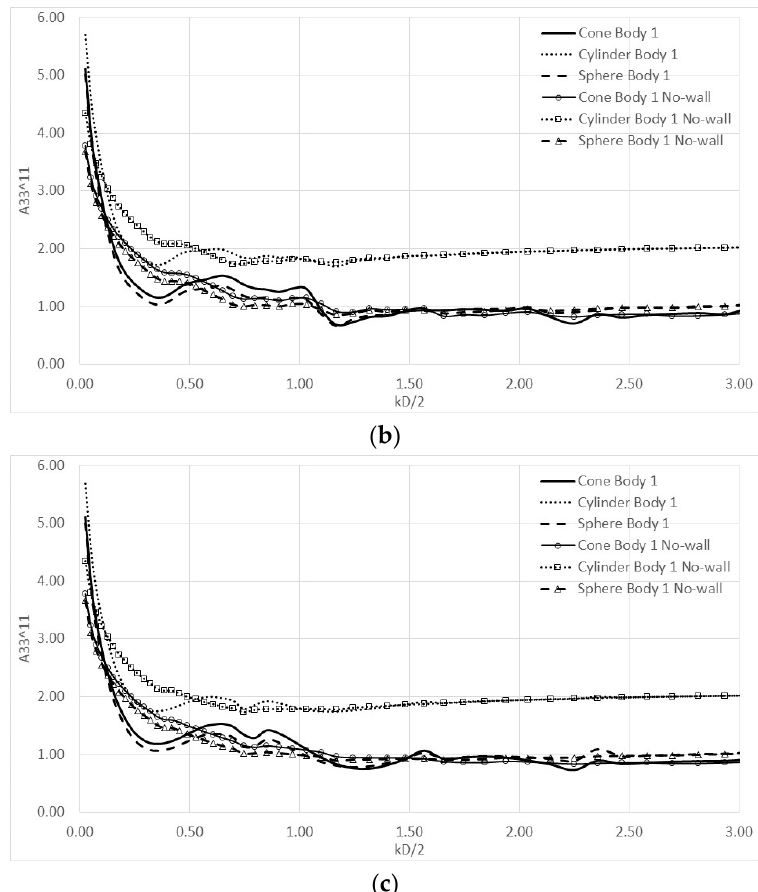
Figure 15. Dimensionless added mass of the 1st floater in the heave direction due to its motion in heave against kD/2, for the three different examined array configurations. Comparison with the corresponding added mass on the same floater of the arrays without the presence of the breakwater: ( a ) parallel arrangement, C 1 ; ( b ) rectangular arrangement, C 2 ; ( c ) perpendicular arrangement, C 3 .